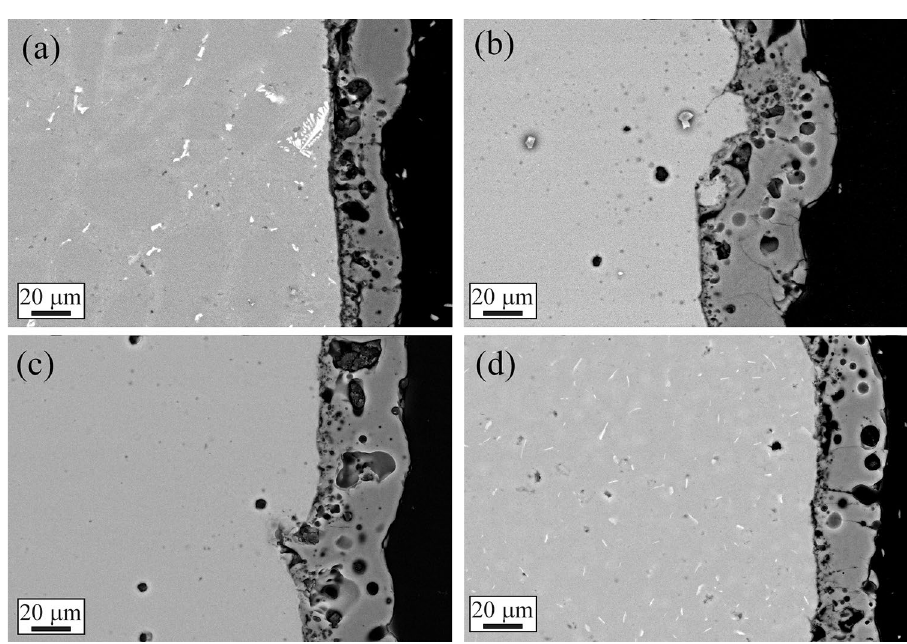
Figure 9. Scanning electron microscope (SEM) images, backscattered electron mode, of the cross-sections of the samples after PEO treatment: cast sample ( a ), as printed sample ( b ), annealed sample ( c ), and solution treated sample ( d